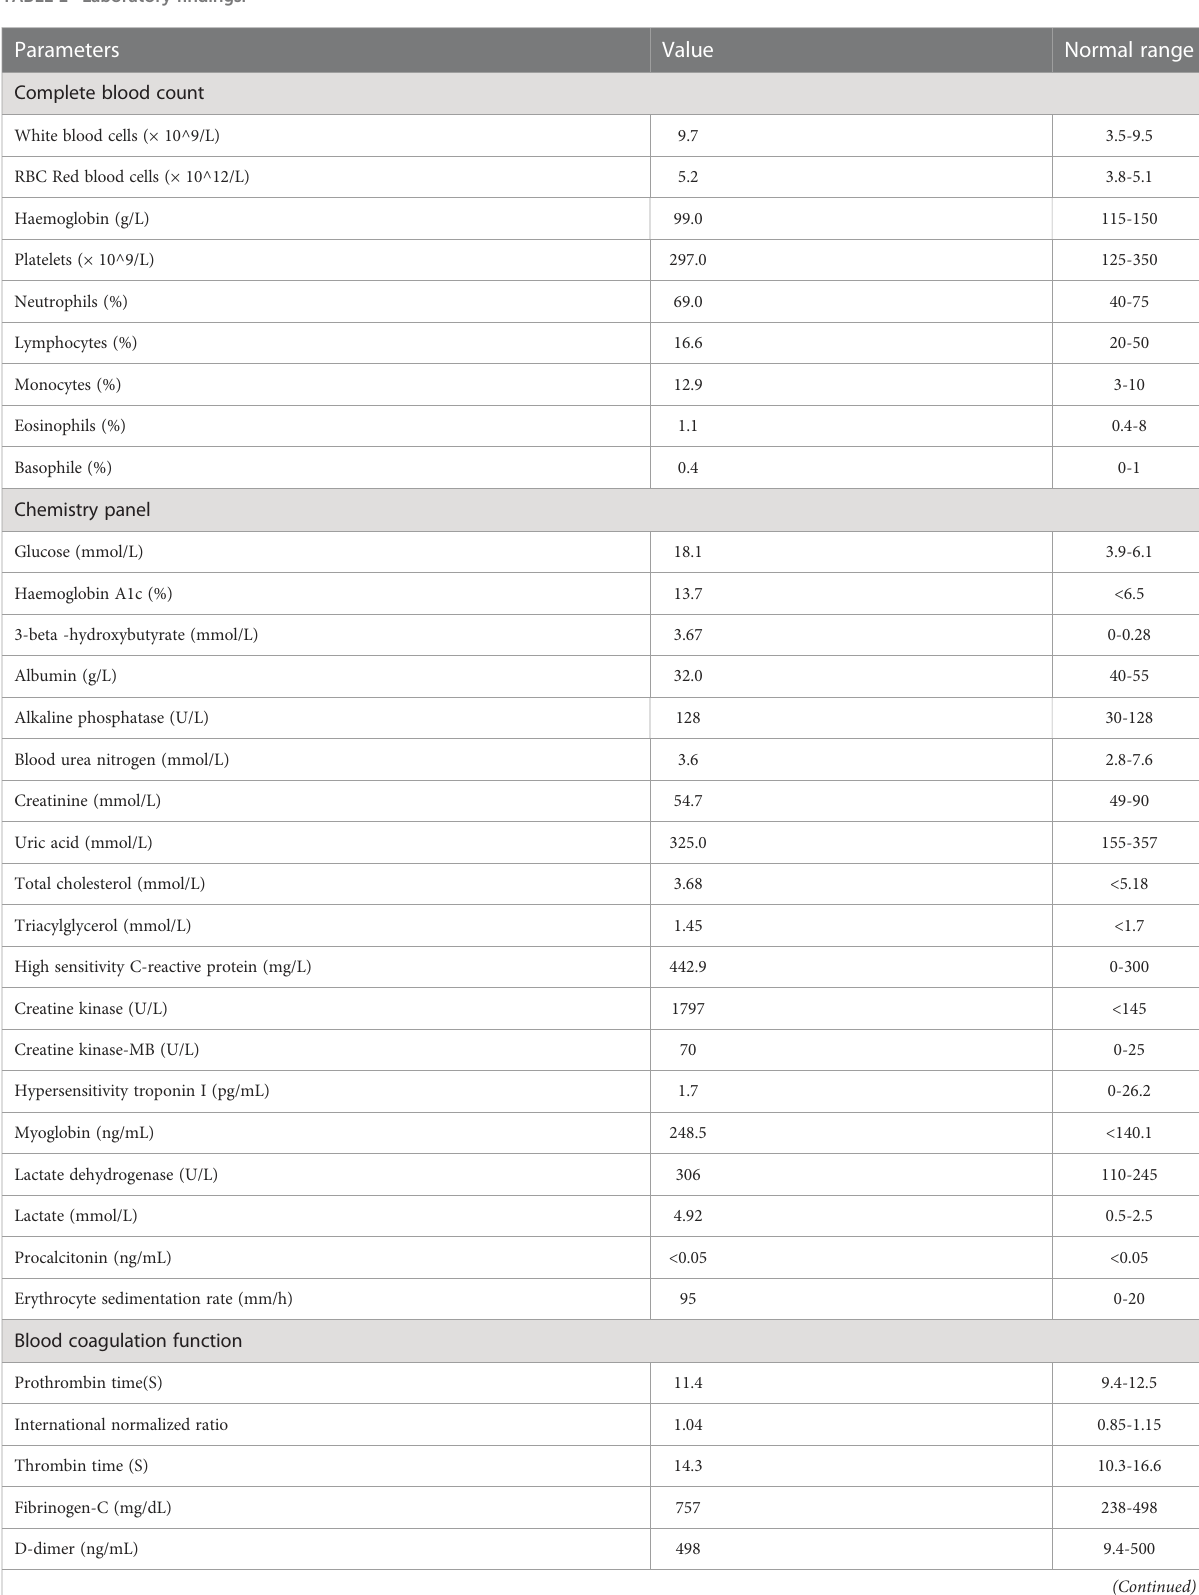
TABLE 1 Laboratory fi